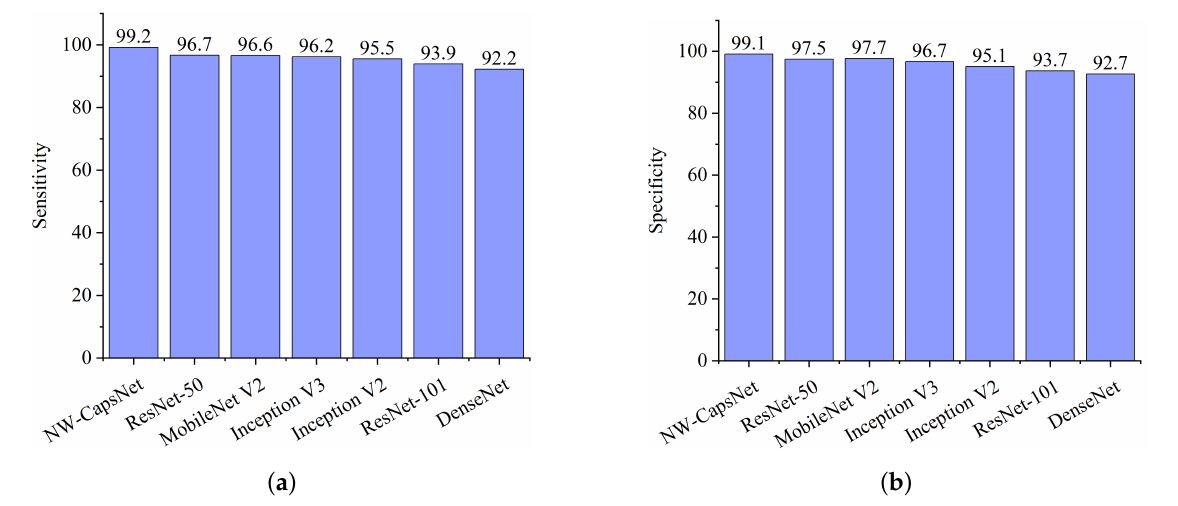
Figure 3. Comparison report of our model and selected pre-trained models. ( a ) Sensitivity result of the pre-trained models, including our proposed NW-CapsNet model. ( b ) Specificity result showing that our proposed model outperforms the selected pre-trained models. Table 4. Comparison study of the proposed model with state-of-the-art COVID-19 image-based models.